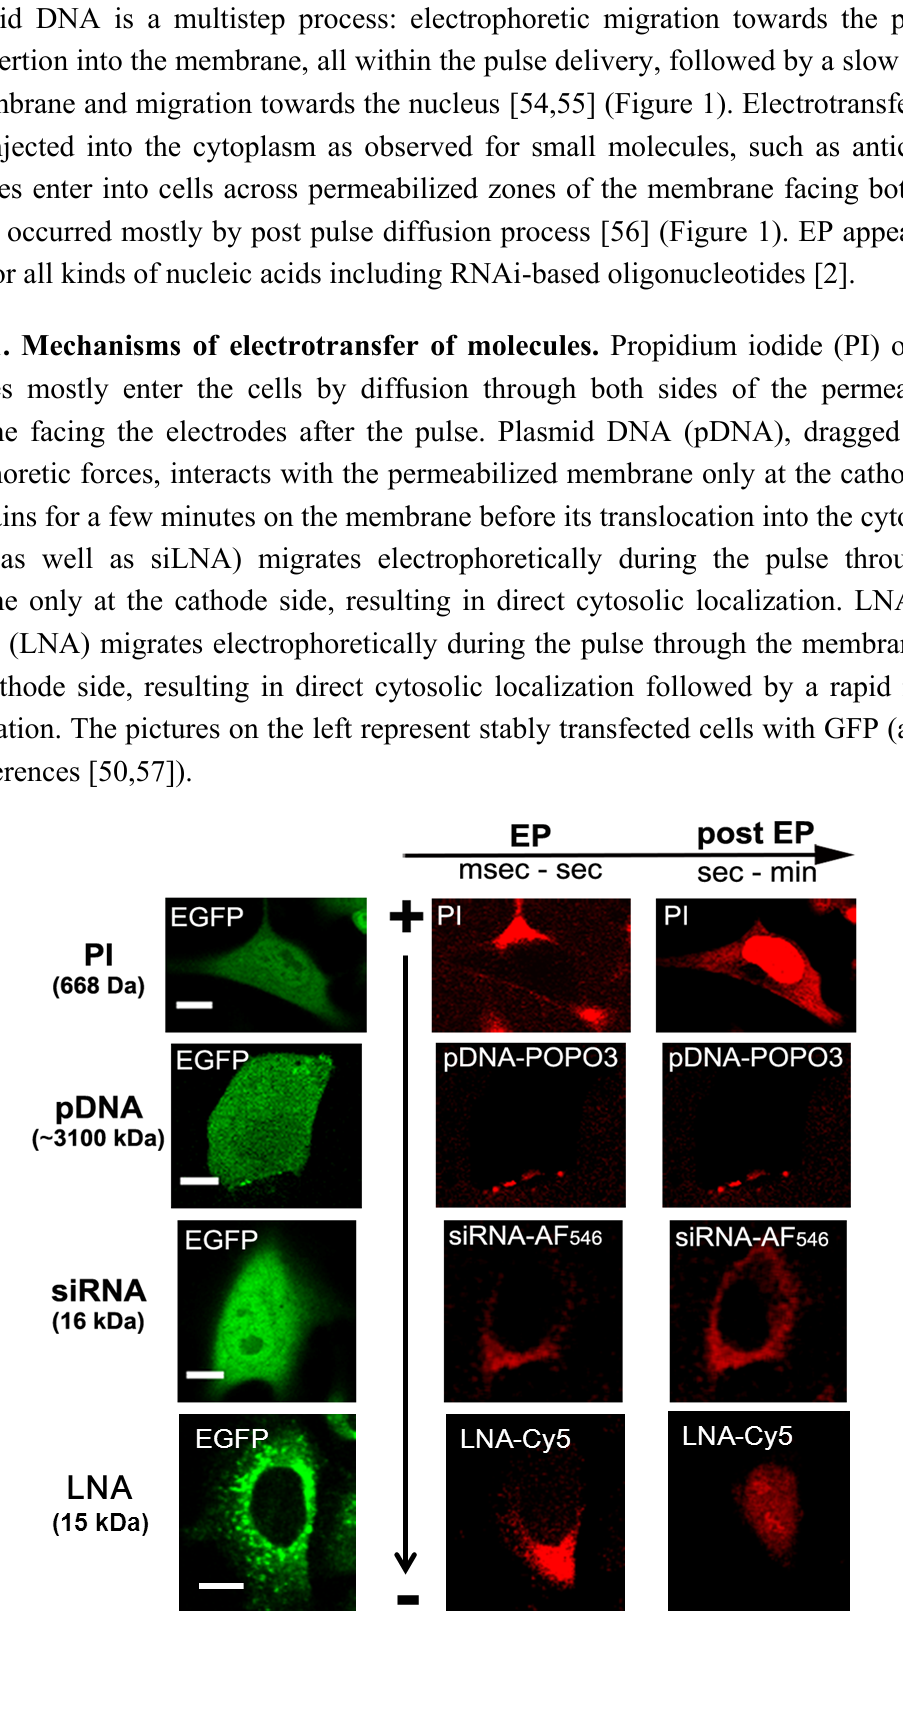
molecules mostly enter the cells by diffusion through both sides of the permeabilized membrane facing the electrodes after the pulse. Plasmid DNA (pDNA), dragged by the electrophoretic forces, interacts with the permeabilized membrane only at the cathode side and remains for a few minutes on the membrane before its translocation into the cytoplasm. membrane only at the cathode side, resulting in direct cytosolic localization. LNA-DNA